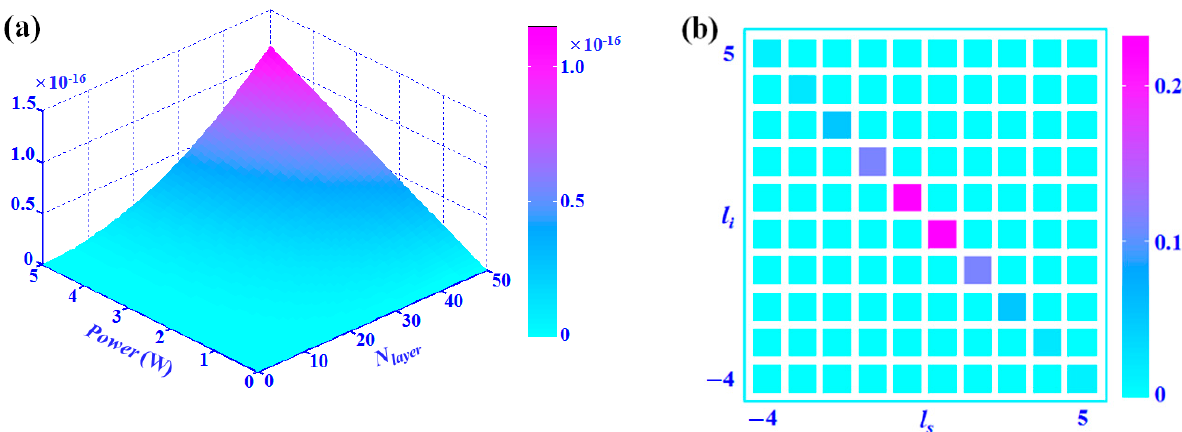
Figure 5. ( a ) The generation efficiency of entangled states for the case ( l p = 0 & q = 1/3) corresponding to varying pump power and layer number. ( b ) The coincidence probabilities as a function of l s and l i for ( l p = 0; q = 1/3).